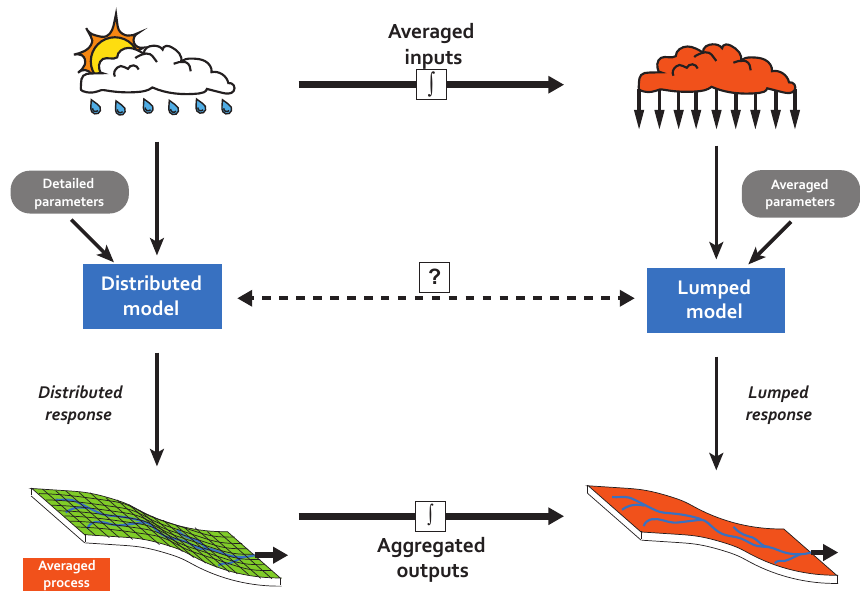
Figure 2. Aggregation and scaling schematic following Wood